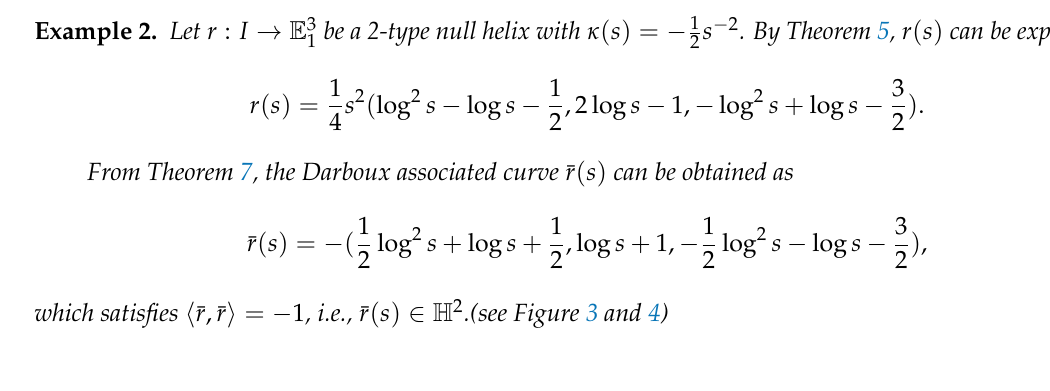
Figure 2. r (red) and ¯ r (green) on S 2